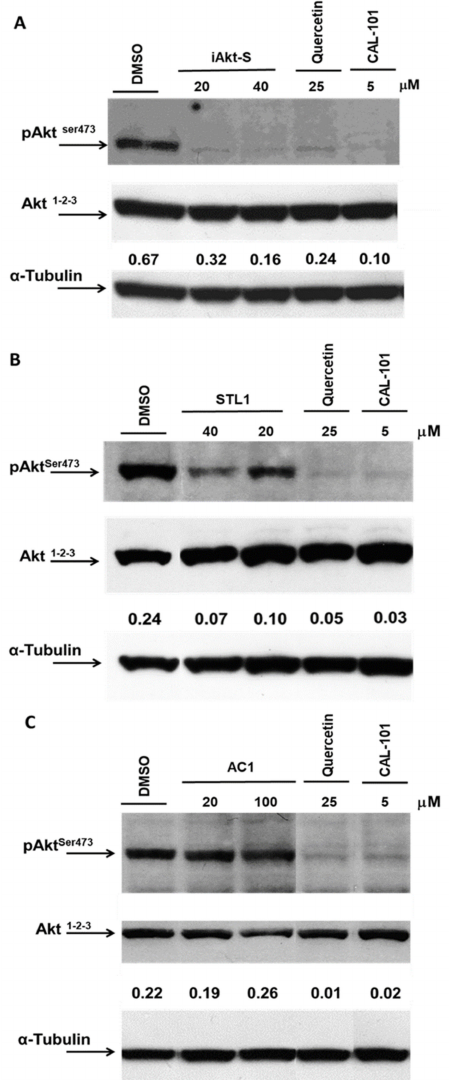
Figure 6. Effect of AKT inhibitors HG3 cells. Cells (1 × 10 6 /mL) were treated for 1 h with DMSO (0.1% v/v ), quercetin (25 µ M), CAL-101 (5 µ M) and iAKT-S (IQO, 20–40 µ M) ( A ); ZINC2429155 (STL1, 20–40 µ M) ( B ) and ZINC1447881 (AC1, 20–100 µ M) ( C ). Immunoblots were performed using the anti-phospho-AKT (p-AKT) antibody (upper panel). After two rounds of stripping, the blot was reprobed using the anti-AKT1-2-3 antibody (middle panel) followed by the anti- α − tubulin antibody. Densitometric analysis was calculated measuring optical density of p-AKT bands normalized respect to the expression of AKT and α -tubulin (pAKT/AKT/ α -tubulin; numbers between the middle and lower panels). The blots are representative images of three independent